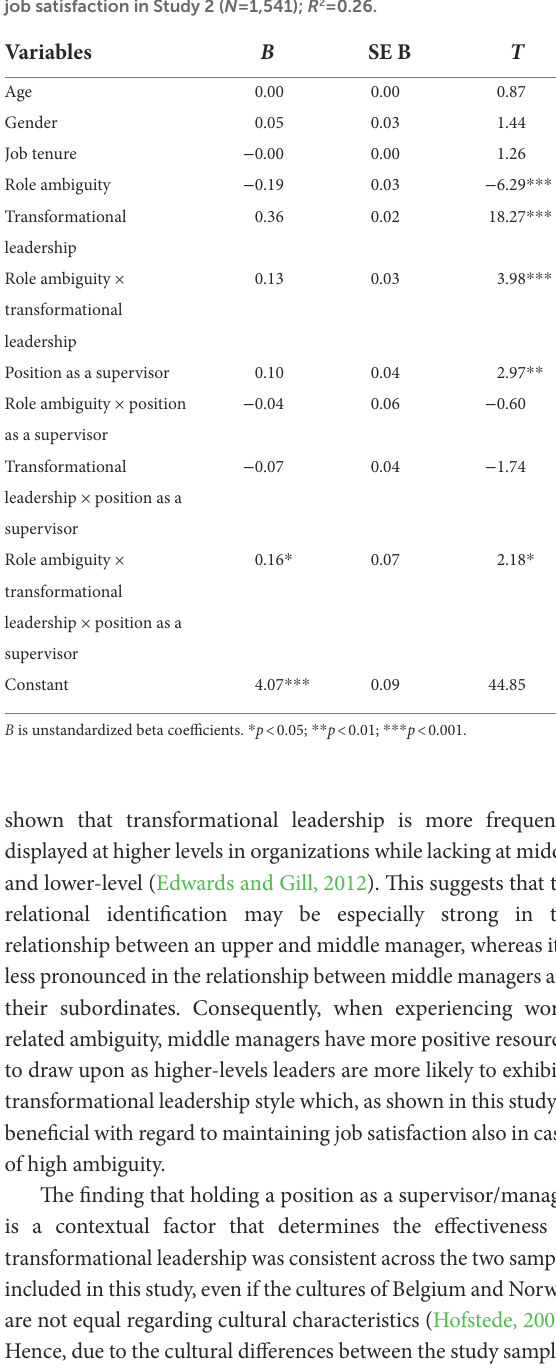
TABLE 4 Two-and three-way interactions between role ambiguity, transformational leadership, and position as a supervisor regarding job satisfaction in Study 2 ( N = 1,541); R 2 =